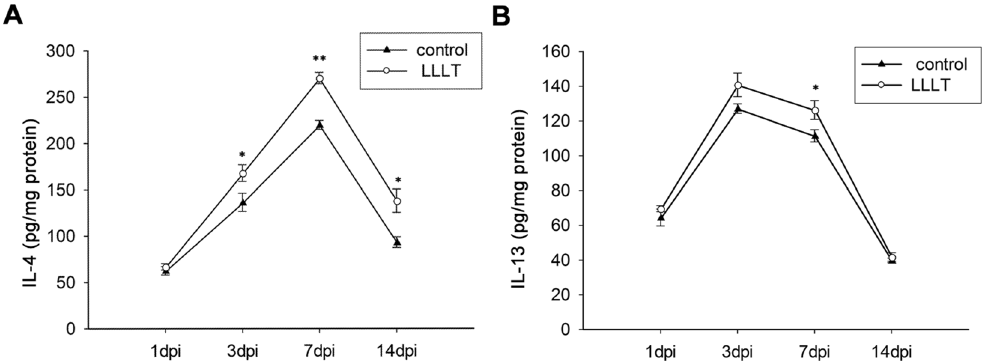
Figure 5. LLLT increases IL-4 and IL-13 expression. ( A ) Time course of IL-4 relative expression in control and LLLT groups. ( B ) Time course of IL-13 relative expression in control and LLLT groups. IL-4, interleukin 4. IL- 13, interleukin 13. (n = 3 rats per group * P < 0.05; ** P < 0.01, compared with